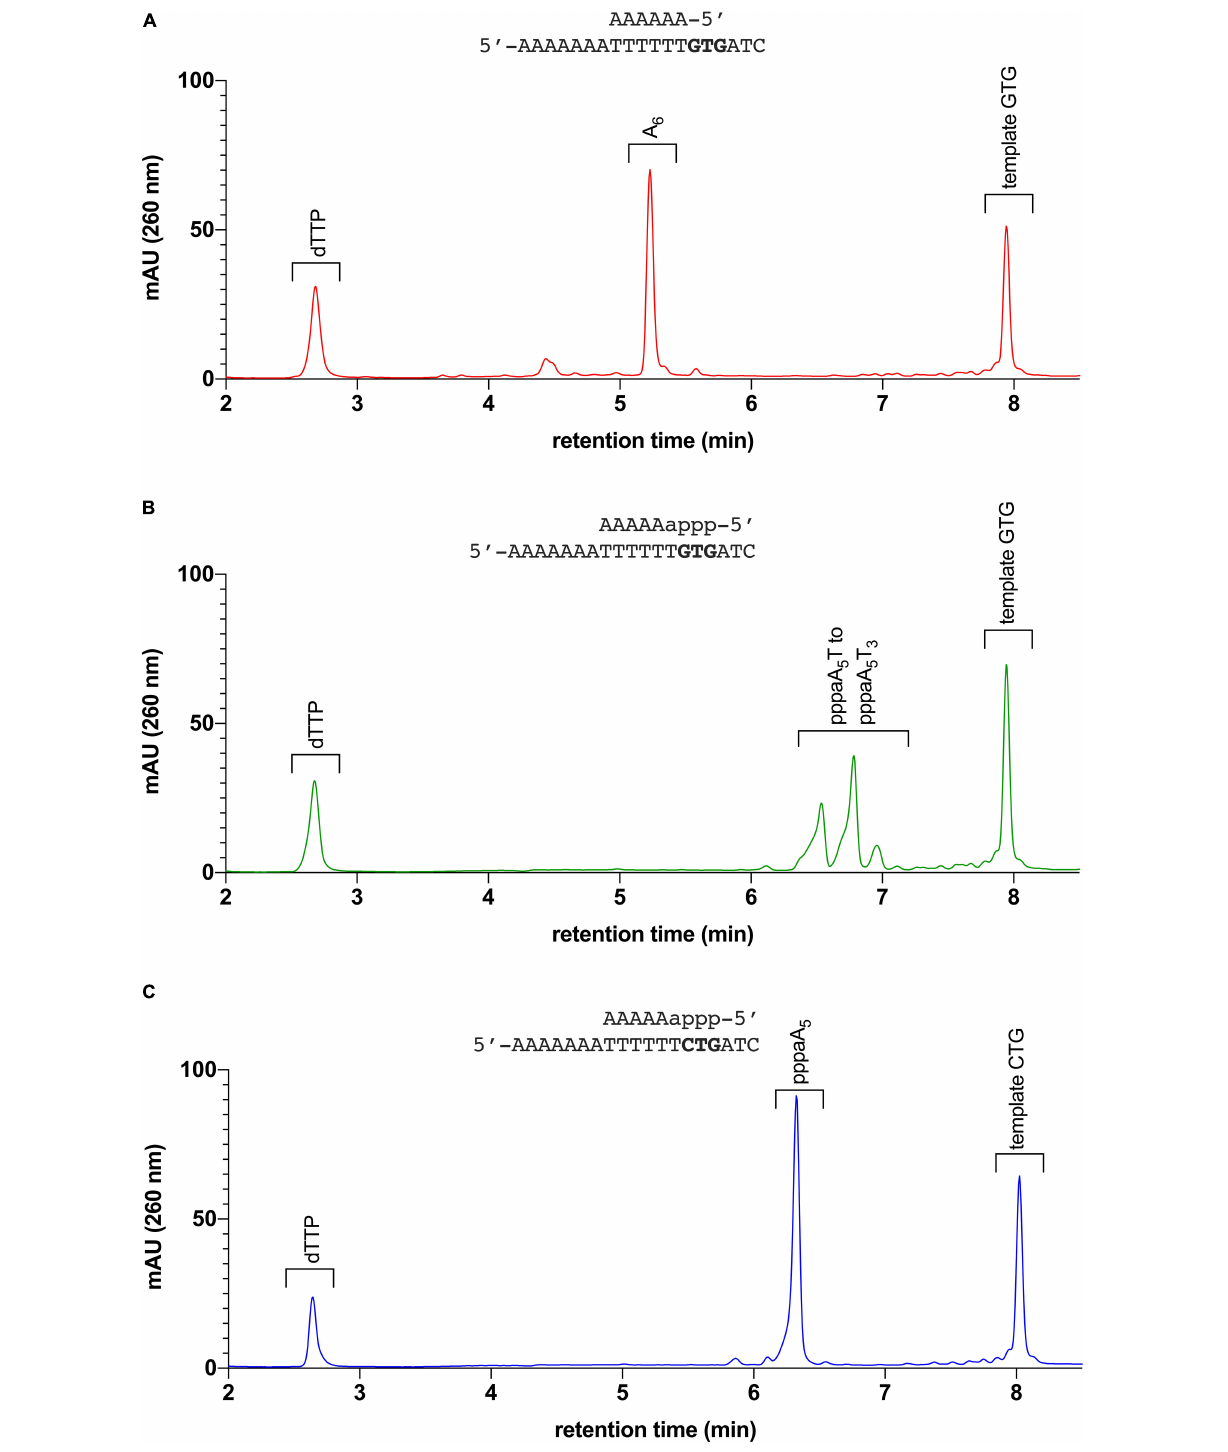
Frontiers in Microbiology |